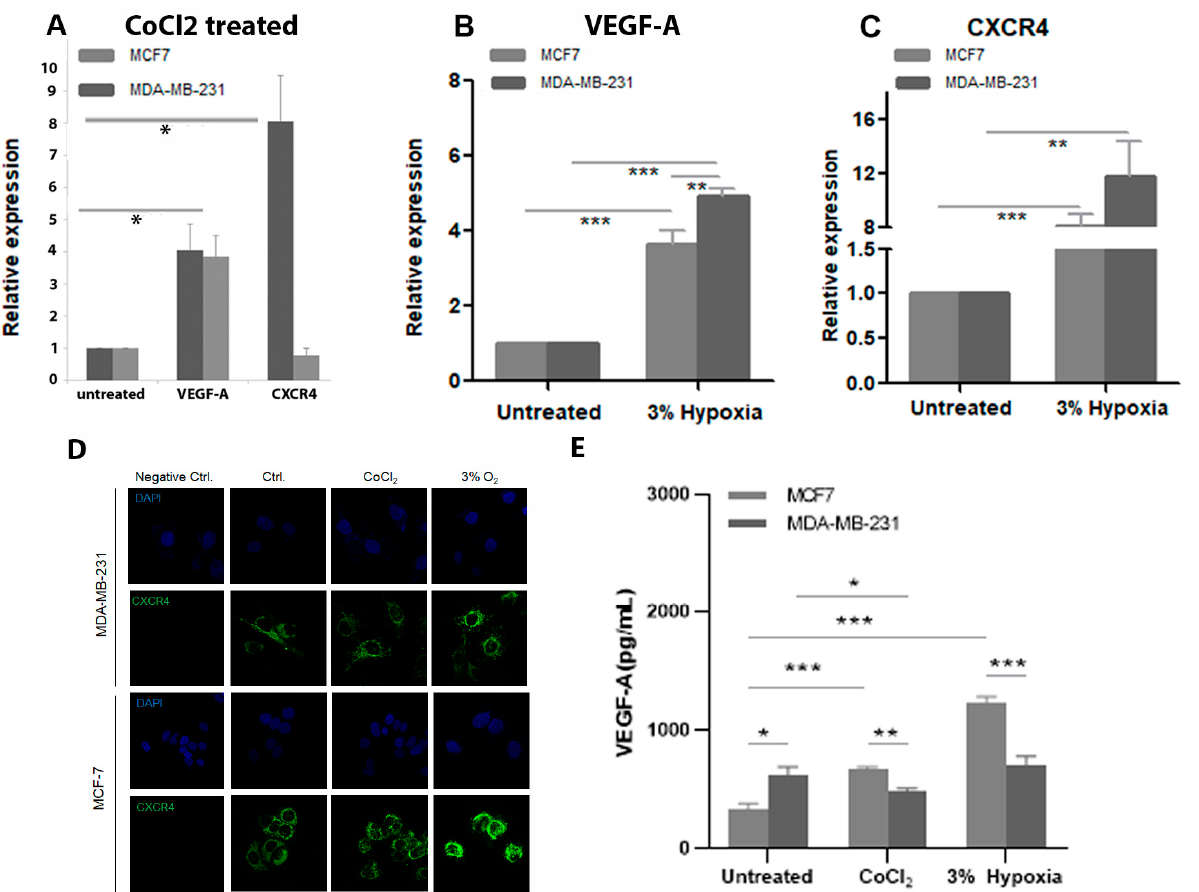
Figure 3. Gene and protein expression of VEGF-A and CXCR4 following treatment with CoCl 2 or low oxygen culture. Graphical representation of qPCR data for mRNA expression levels of VEGF-A and CXCR4 in MDA-MB-231 and MCF7 cells treated with 400 µ M CoCl 2 for 24 h ( A ). Untreated cells are included as control. Bars represent an average of n = 3 individual experiments. Note the significant increase in VEGF-A expression ( p = 0.02) and CXCR4 expression ( p = 0.04) in the treated MDA-MB-231 versus the untreated. Following treatment by culture under 3% hypoxia note that there was a significant difference in expression of VEGF-A between both cell lines and their controls (n = 3, MDA-MB-231 p < 0.001, MCF7 p < 0.001) ( B ). This was also apparent between the hypoxia treated MCF7 and MDA-MB-231 with expression being significantly higher in the MDA-MB-231 ( p = 0.007) ( B ). While for CXCR4 expression both cell lines showed significantly increased expression after hypoxia treatment compared to controls (n = 3, MDA-MB-231 p < 0.001, MCF7 p = 0.002) ( C ).To determine if either treatment led to modification of protein expression, cells of both cell lines were exposed to CoCl 2 and hypoxia and stained for expression of CXCR4 ( D ). For both cell lines CXCR4 expression increased slightly under both conditions compared to controls. Representative images of n = 3, original magnification 40 × . ( E ) VEGF-A protein expression following exposure to CoCl 2 or low oxygen levels was determine by ELISA. In untreated cells, secreted levels of VEGF-A were higher in the untreated MDA-MB-231 compared to untreated MCF7 ( p = 0.01). In the MCF7 cells both CoCl 2 and hypoxia treatment increased secretion of VEGF-A (both p < 0.001). Whereas, in the MDA-MB-231 cells CoCl 2 decreased secretion of VEGF-A ( p = 0.04), and hypoxia had no effect. p values * p value < 0.05, ** p value < 0.005, *** p value ≤